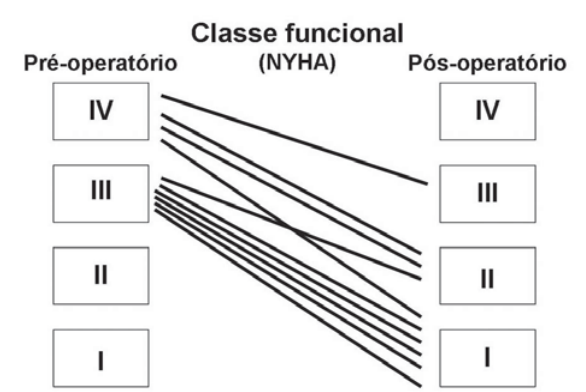
Fig. 1 - Evolução da classe funcional após a cirurgia. NYHA: New York Heart Association